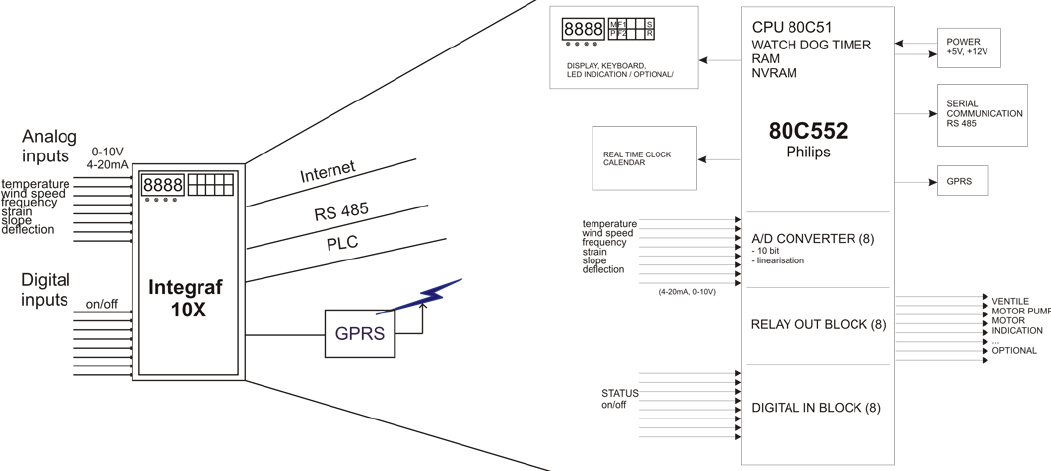
Figure 2. Block schema of CERM client